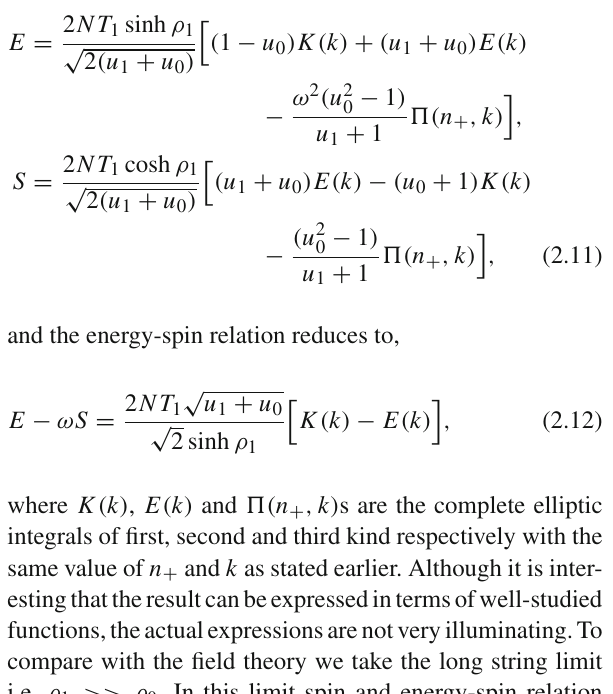
and solving this we